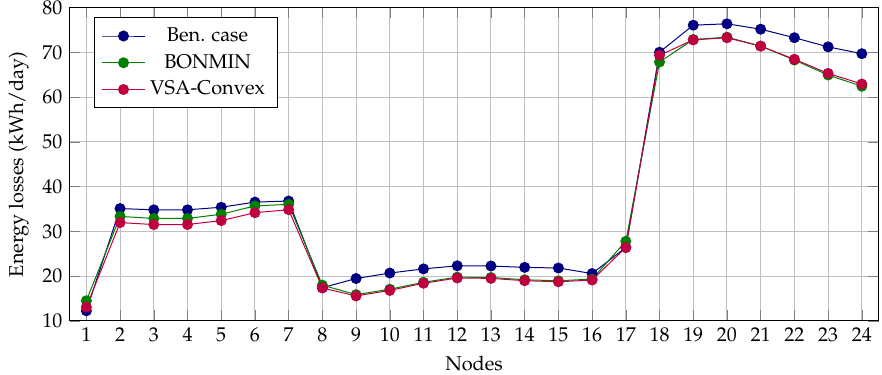
Figure 2. Energy loss behavior for the benchmark case and the solution methods.